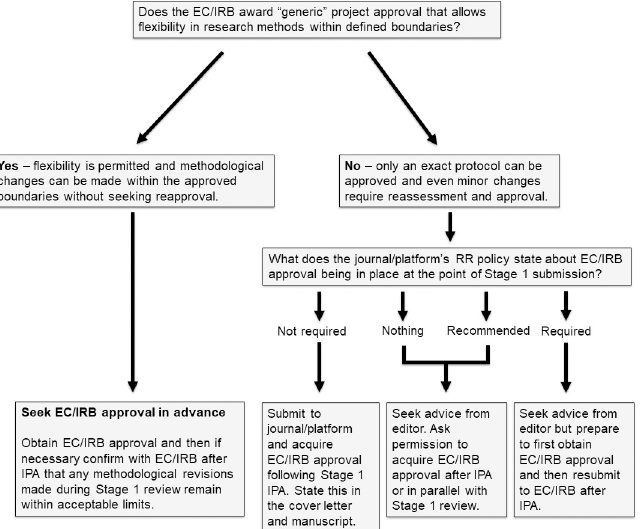
Fig 1. Registered Reports Ethics Flowchart. EC, ethics committee; IPA, in-principle acceptance; IRB, institutional review